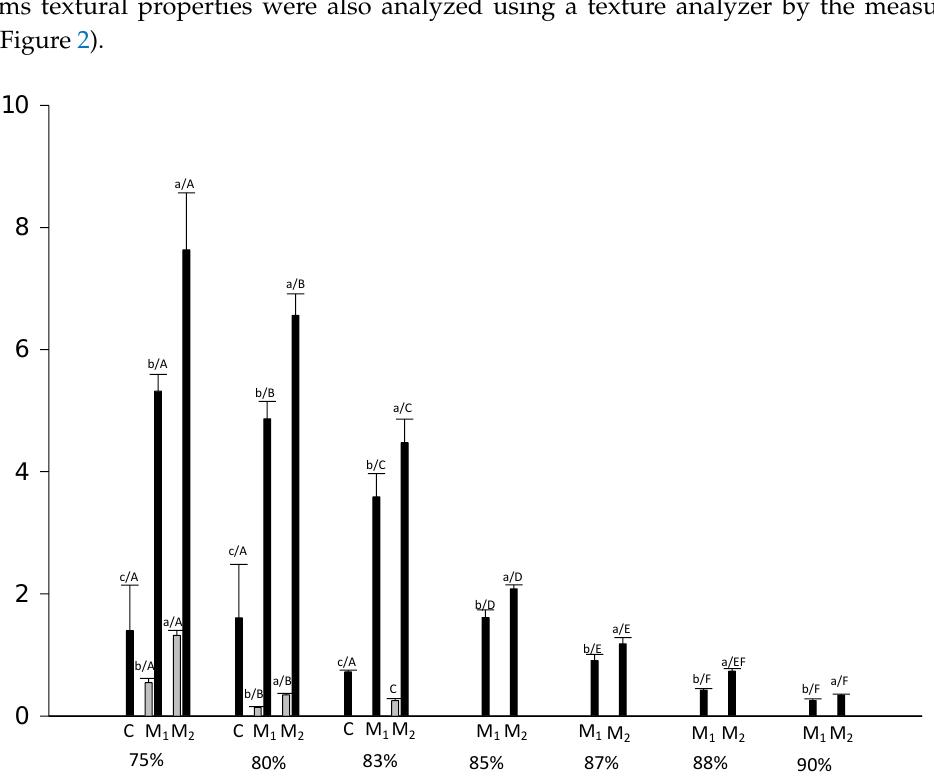
Figure 2. Hardness value of systems formed using three different flours C, M 1 and M 2 at different conditions (black HC and grey CC) and different moisture content (75%, 80%, 83%, 85%, 87%, 88% and 90%). Different letters indicate significative differences among samples ( p ≤ 0.05) where the small letters refer to the differences due to the flours and capital letters refer to the moisture content at the same preparation condition.